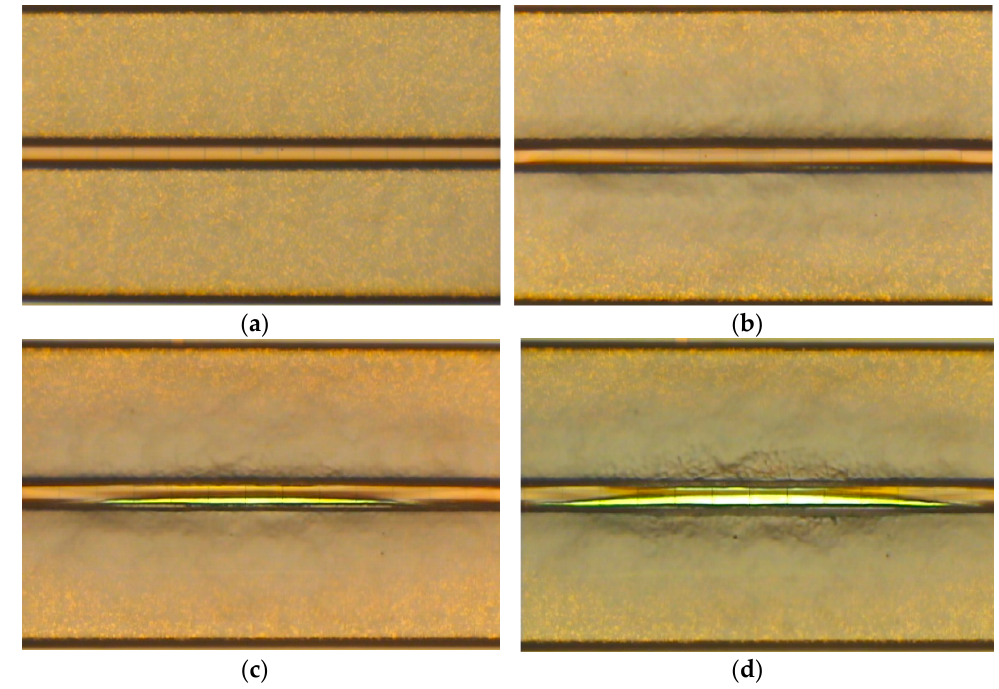
Figure 14. PM plates of a tested sample: ( a ) before testing; ( b ) after 10 million cycles; ( c ) after 20 million cycles; ( d ) after 30 million cycles.